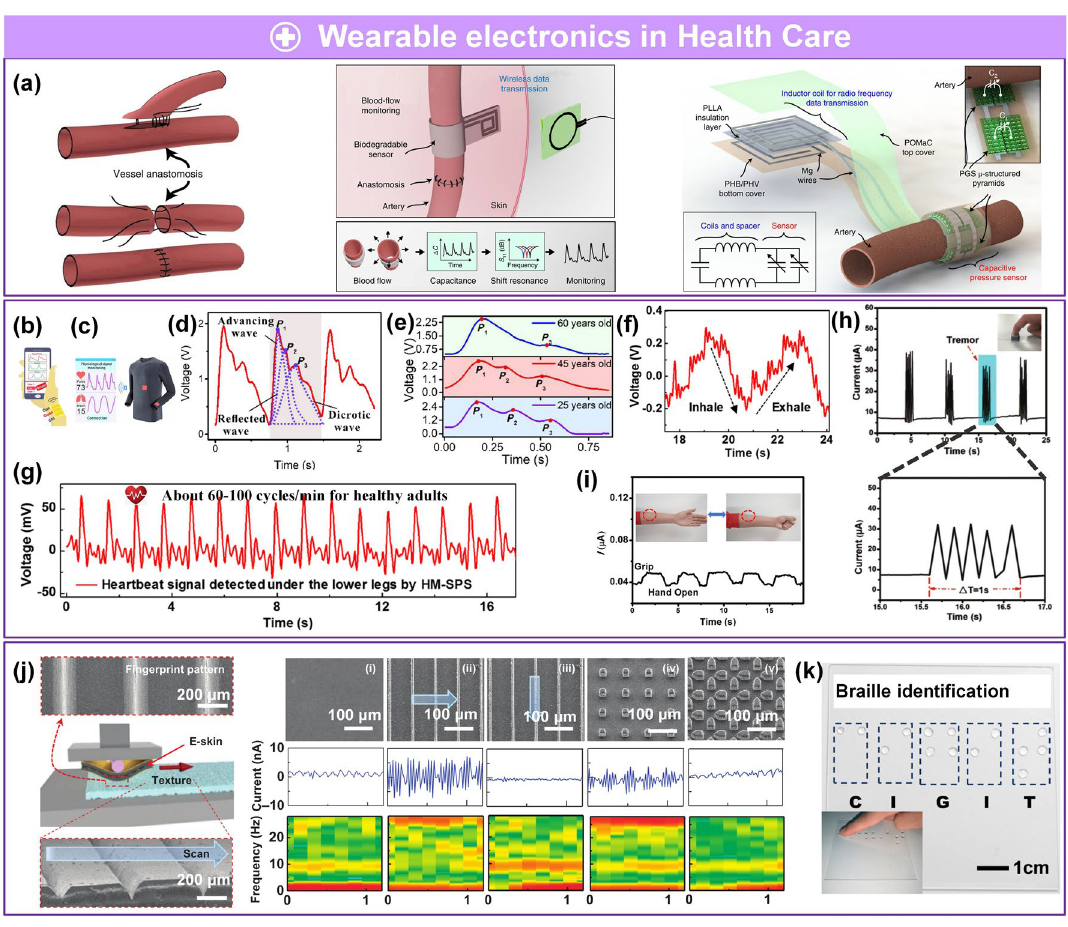
Fig. 16 Applications as wearable electronics. a E-skin in vivo monitoring of blood flow [1]. Copyright (2019) Springer Nature. b E-skin in vitro [2]. Copyright (2018) Wiley–VCH. c Intelligent cloths [31]. Copyright (2020) The Authors. d‑e Monitoring of physiological for beating of